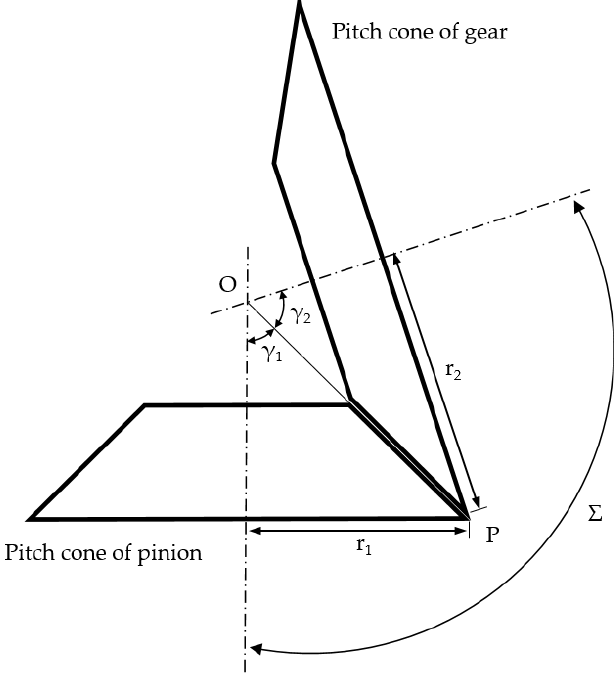
Figure 1. Pitch cones of the gear pair elements.